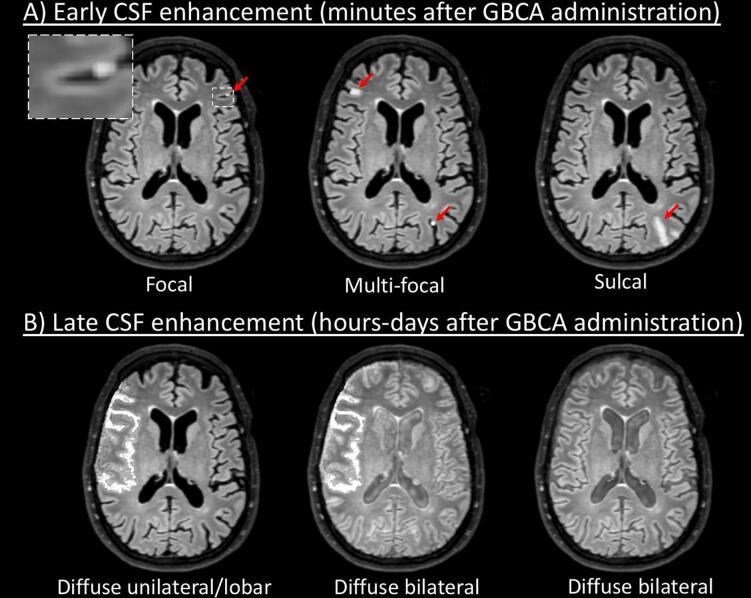
Schematic representation of different appearance patterns of CSF enhancement. A) Typical presentations of CSF enhancement within minutes after GBCA administration. These patterns were described in different diseases, including ischemic stroke, hemorrhagic stroke, carotid artery disease treatment, aneurysm treatment, cardiac surgery, multiple sclerosis, memory clinic patients, Susac syndrome (lesions were frequently observed in the posterior fossa). These types of CSF enhancement typically appear within minutes after GBCA administration. Meningitis was an exception to this: cases with meningitis typically display diffuse meningeal enhancement within minutes after GBCA administration on pcT2wFLAIR images. B) Typical presentations of CSF enhancement within hours to days after GBCA administration. Patterns like these were described in acute ischemic stroke, hemorrhagic stroke, treatment for carotid artery disease, aneurysm treatment, cardiac surgery, and familial amyloid polyneuropathy. Note: the CSF enhancement patterns were manually drawn on an example pre-contrast FLAIR image from our previous study (Villringer, 2017)using online photo editor software (www.pixlr.com).’